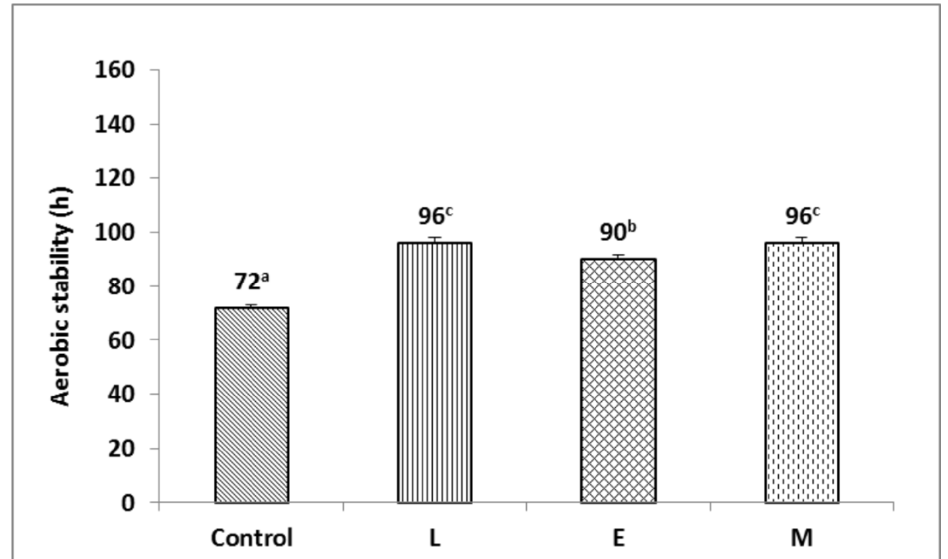
Figure 3. Time required for Flammulina velutipes spent mushroom substrate silages temperature to exceed room temperature by 2 °C after exposure to air (one-way ANOVA: F = 117.7, p = 0.000). L, lactic acid bacteria; E, cellulase; M, the mixture of lactic acid bacteria and cellulase. a-c Means with different superscripts differed significantly ( p < 0.05).